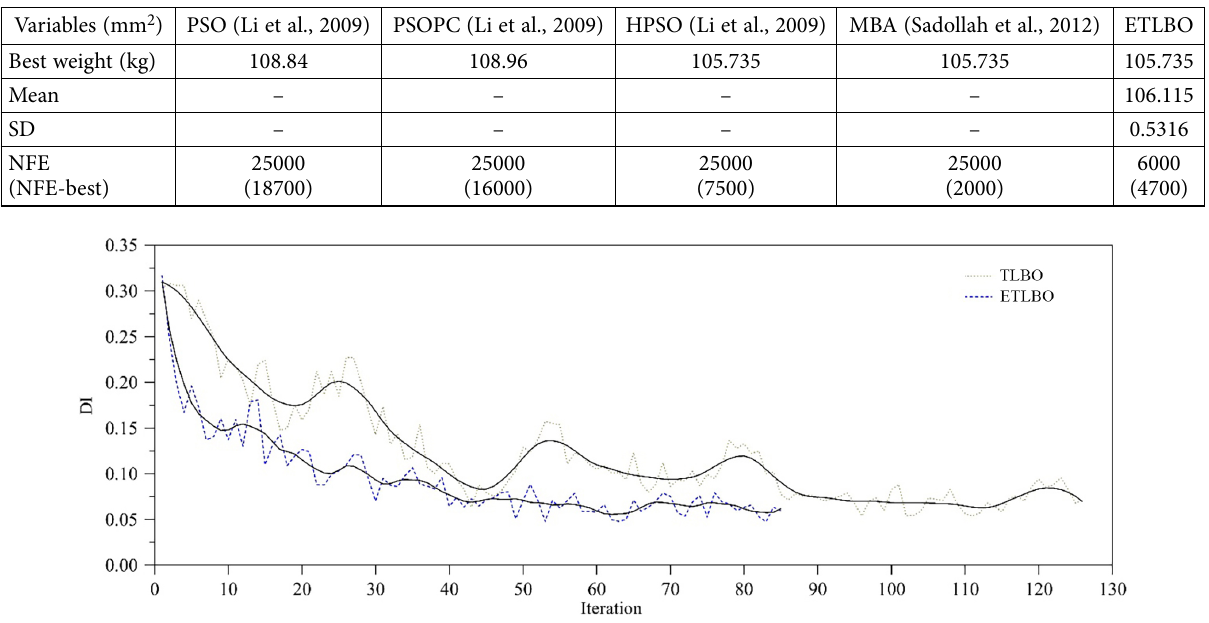
Table 4. Comparison of results algorithm in literature for the 15-bar truss example